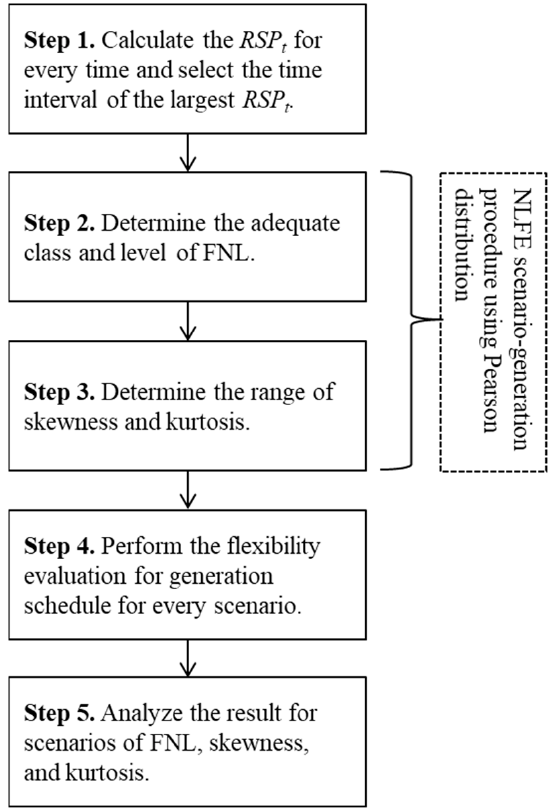
Figure 3. Procedure for the effect of NLFE characteristics on flexibility.